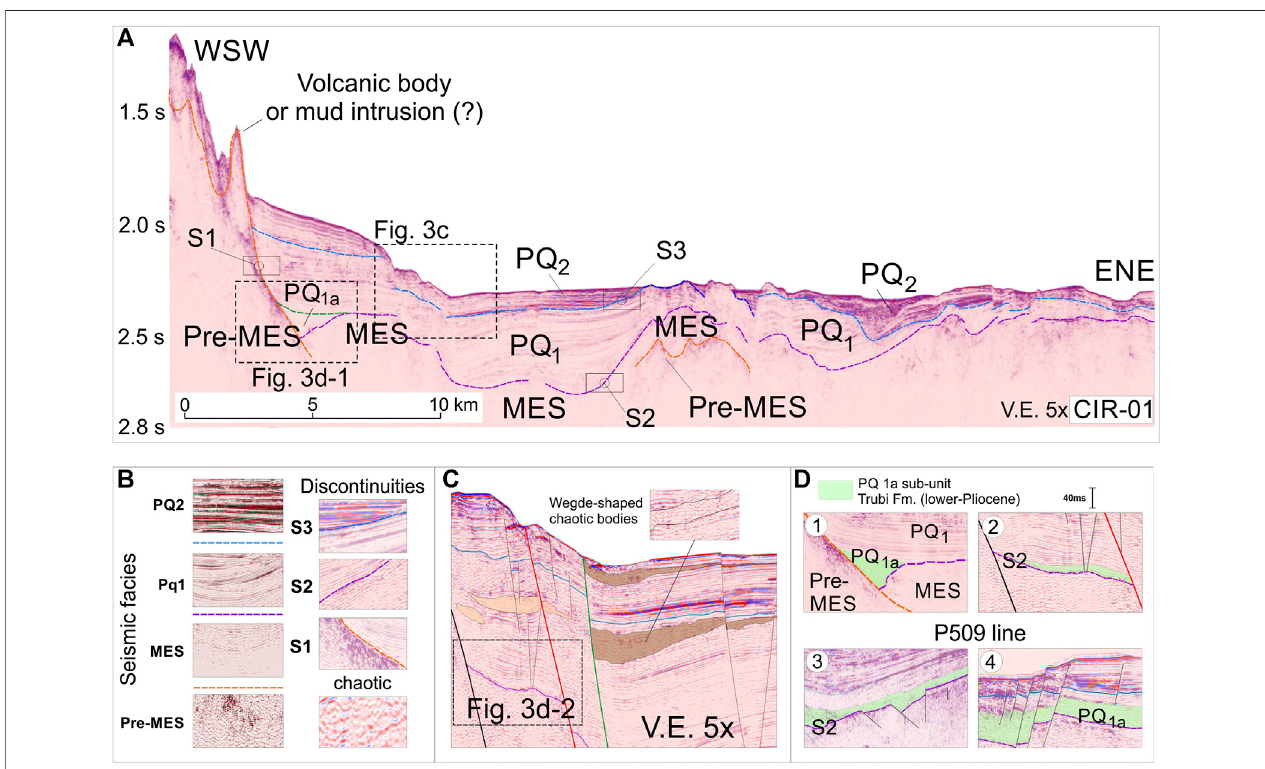
FIGURE 3 | (A) Seismostratigraphic analysis performed over the representative CIR-01 line displaying the recognized seismic facies/units and bounding discontinuities (B) . (C) In the upper part of the Pliocene section and within the Pleistocene succession, wedge-shaped chaotic bodies occur supporting syntectonic sedimentation during theconsidered timeinterval. (D) ThebaseofPliocenesection isoccasionallyand discontinuously fl ooredbyasemitransparentseismic unit(PQ1a) interpreted as a Zanclean in age Trubi Fm.